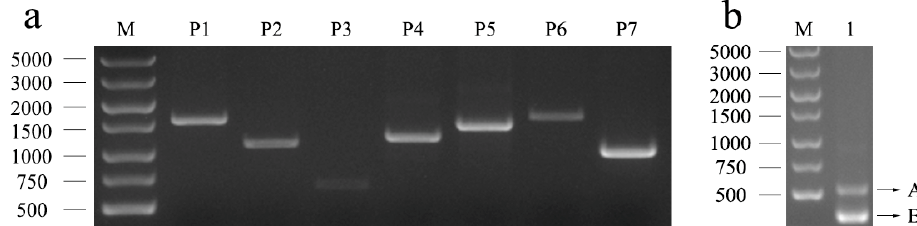
Figure 1. PLAG1 3 ′ -UTR amplification in Hu sheep: Agarose electrophoresis of ( a ) primers P1, P2, P3, P4, P5, P6, and P7, respectively; ( b ) nested PCR (P9 primer) used to amplify the 3 ′ -UTR of PLAG1 . M: DNA marker (DL5000); 1: P9 amplification product.